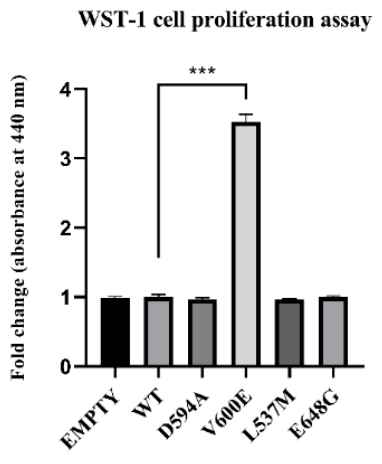
Figure 4. Effect of BRAF mutant overexpression in THLE-2 cells on cell proliferation. A statistically significant augmentation in hepatocyte proliferation, when compared with control, was observed in BRAF V600E-transfected cells. The results are presented as a fold change (±SEM) normalized to BRAF WT-transfected cells. The statistical analysis was carried out using ANOVA with Bonferroni correction, n = 3, *** p < 0.001.